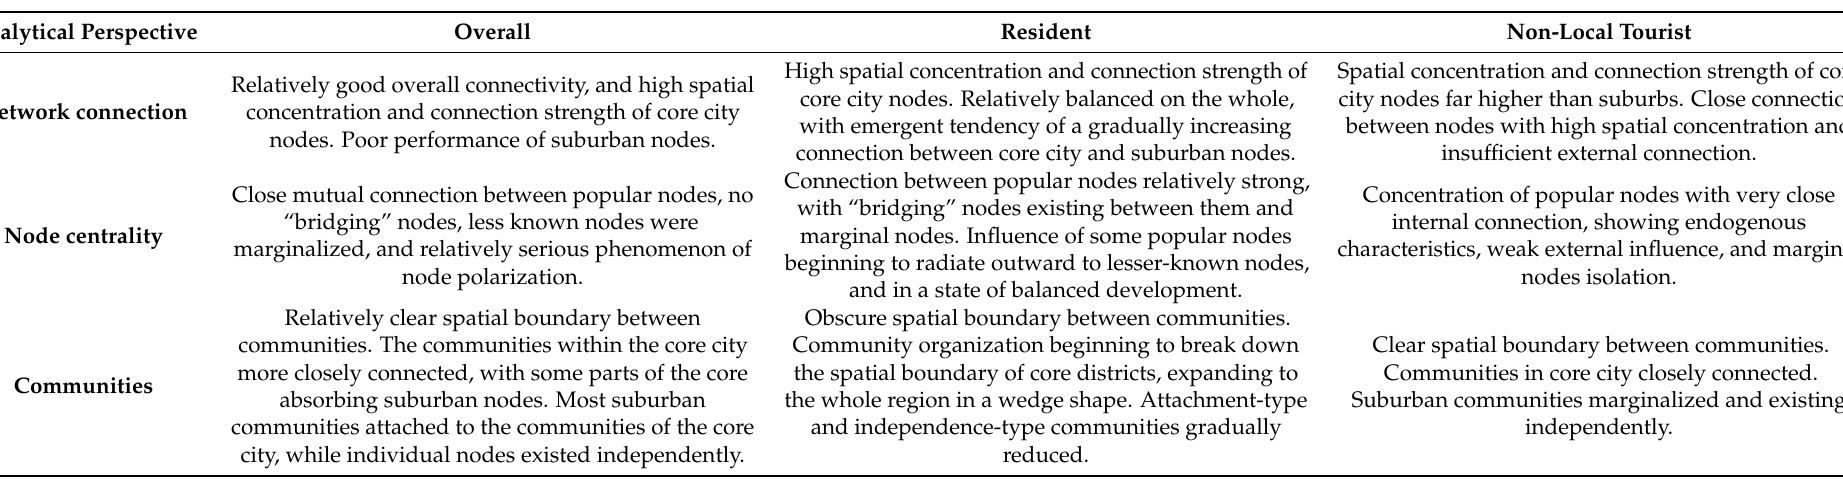
Table 6. Summary of tourism flow network structures under three context types (overall, resident and, non-local